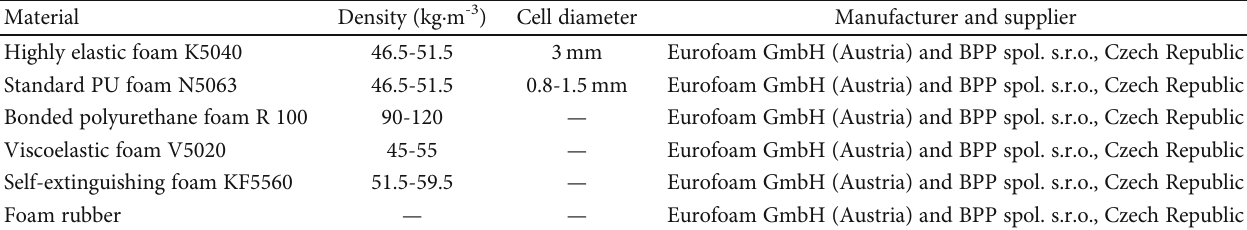
Table 1: Parameters of various samples used in the study (also published in part 1 of the study [15].